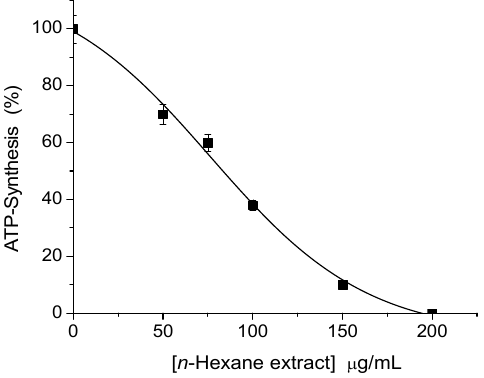
Figure 1. Inhibitory effect of increasing concentrations of n -hexane extract (obtained from aerial parts of S. salignus ) on ATP synthesis rate of spinach thylakoids. Control value was 971 µM ATP / mg Chl × h. The data are results of three